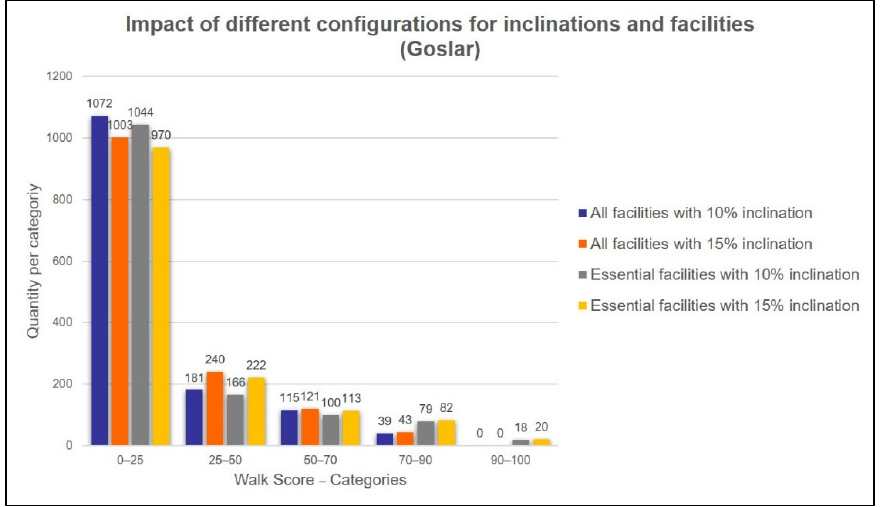
Figure 2. Comparison of walkability under di ff erent assumptions in the city of Goslar. The values on the abscissa re fl ect the WS and are sorted by WS range (e.g., 90–100 represents “walker’s paradise”, which is the highest WS range).